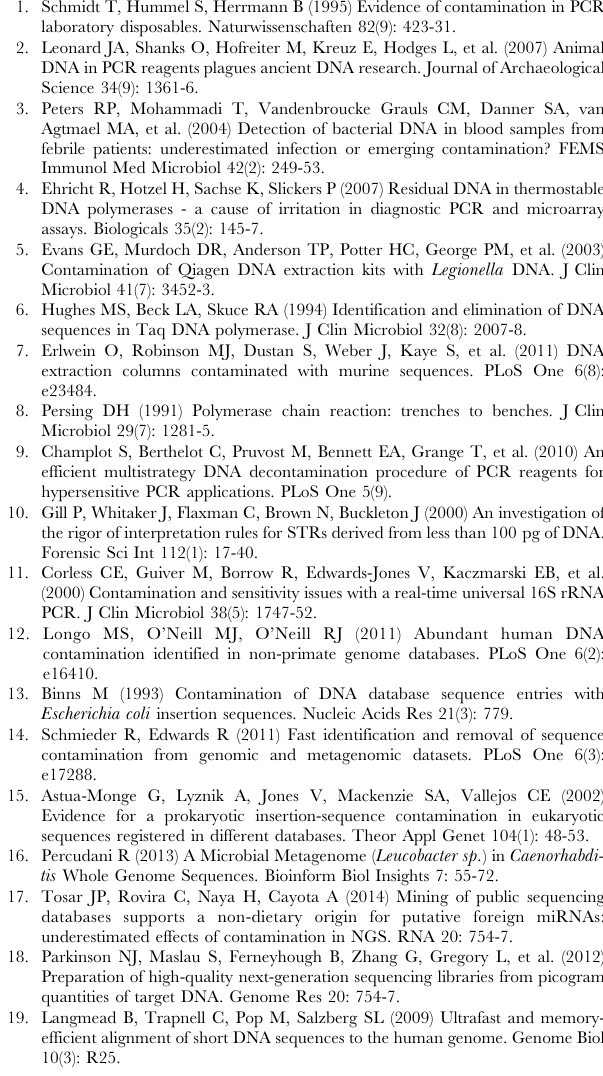
three guanines. On the basis of this analysis, the first fifteen bases, highlighted in gray, were trimmed from each read. Figure S2 Coverage of chloroplast genomes. Reads from the ‘‘Tumor’’ experiment were mapped to a database of chloroplast genomes, and the coverage of genomes with more than 200 matches is depicted here. The B. hypnoides genome was removed from further analysis due to the observed uneven coverage. Table S1 The European Nucleotide Archive accession numbers associated with each sample analyzed in Figure 1. (CSV) Table S2 The SRA accession numbers associated with the samples analyzed in Figures 3 and 4.